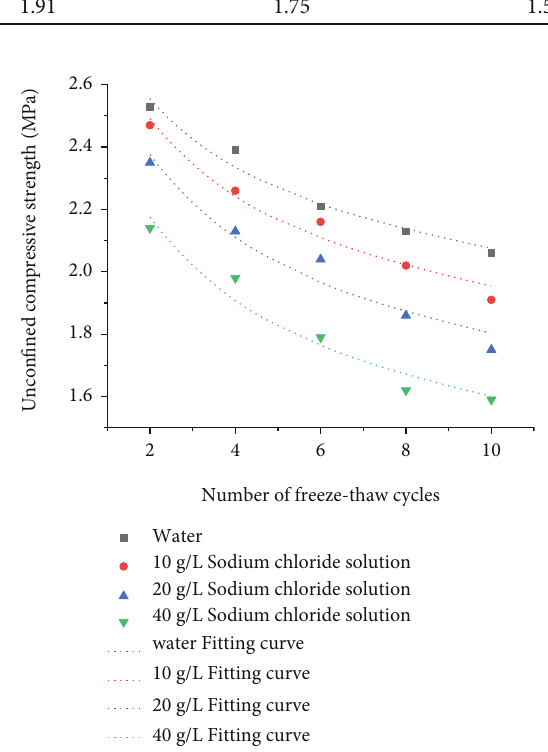
Figure 7: Relationship between uncon fi ned compressive strength of the sample and cycle times.